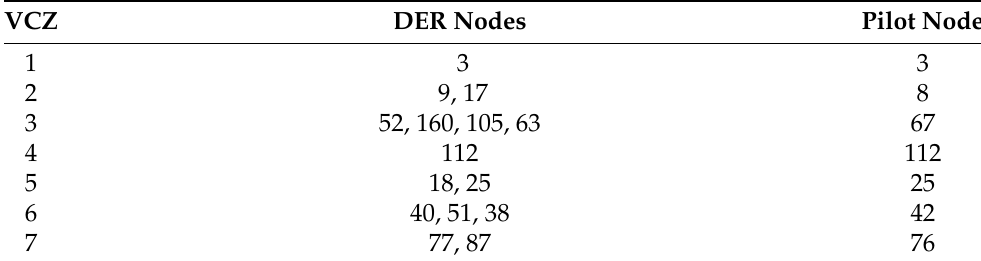
Table 5. PNs and DERs nodes in the 7-VCZ partition.